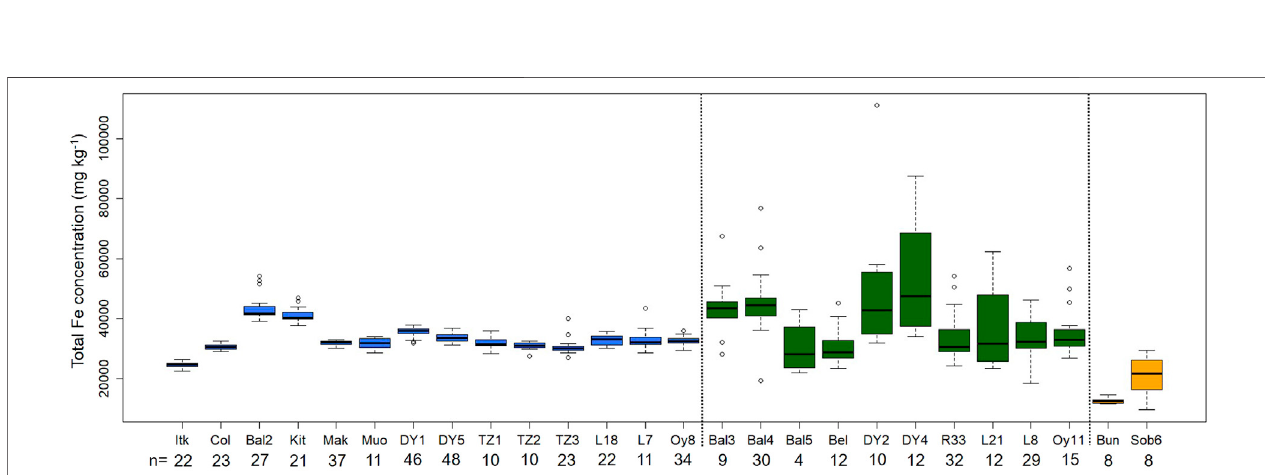
FIGURE 5 | Boxplot of the Fe concentration within selected pro fi les from different types of deposit: Yedoma Ice Complex (blue), Alas (green), and deltaic/ fl uvial deposits (orange). Yedoma Ice Complex deposit pro fi les were selected based on the absence of active layer deposits or fl uvial deposits along the pro fi le. Alas pro fi les locatednearYedoma pro fi lesselected(whenpossible) areshown.Thenumberofsamplesforeach boxplotisgivenbelowlabelsofthe x -axis. Thesamplelabelsreferto Table 1 .